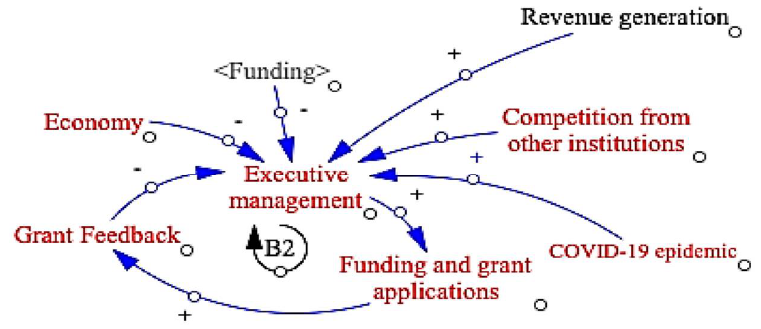
Figure 8. Reinforcing loop B2.